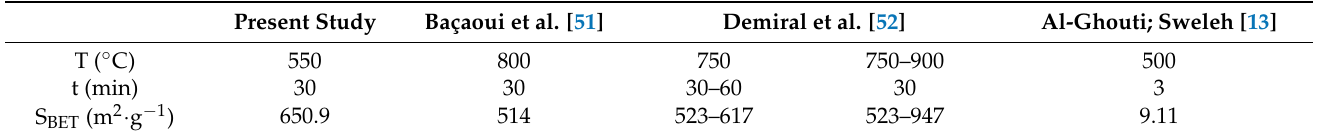
Table 2. Parameters used to obtain the activated carbon from olive wastes.